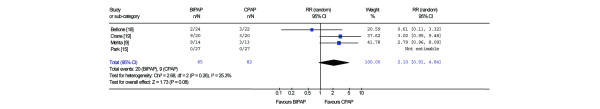
Forest Plot: effect if BiPAP and CPAP on risk of new onset myocardial infarction. BiPAP, bi-level positive airway pressure; CI, confidence interval; CPAP, continuous positive airway pressure; RR, relative risk.